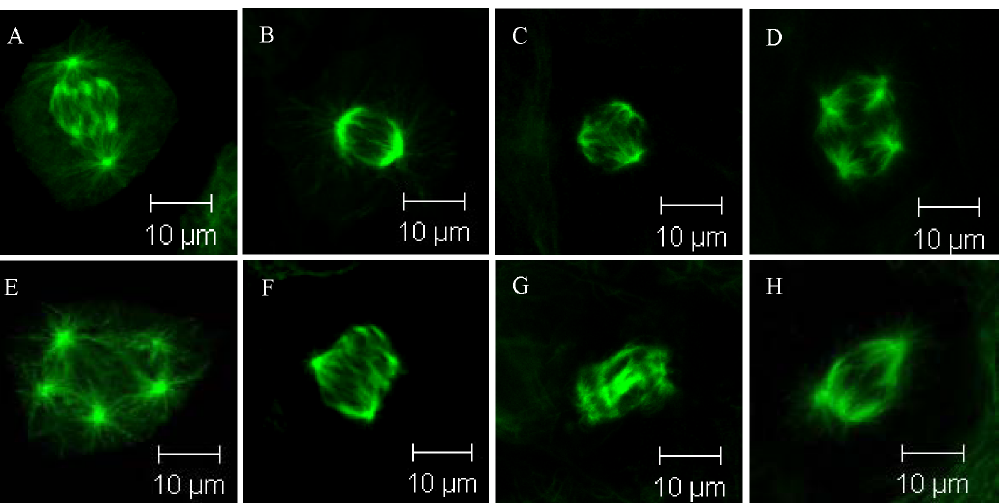
Figure 5. Spindle morphology in osteosarcoma and osteoblast cells. The spindles are stained green by anti- a -tubulin first antibody and FITC-conjugated goat anti-mouse IgG. A and B. Bipolar spindle of MG-63(A) cell and rat calvaria primary osteoblast (B) under 1 g condition. C–E. Multipolar spindle under simulated microgravity in MG-63 cell (C. three polar spindles, D. four polar spindles) and hFOB1.19 cell (E. five polar spindles). F–H. Microtubule arrangement change under simulated microgravity (F. MG-63, G. U-2 OS, H. rat calvaria primary osteoblast).